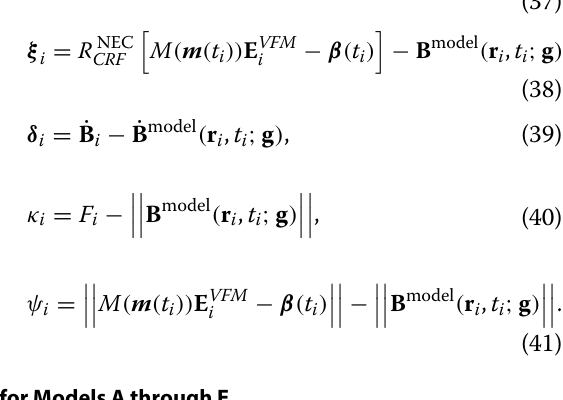
Table 1 Time periods, datasets used, and number of parameters for Models A through